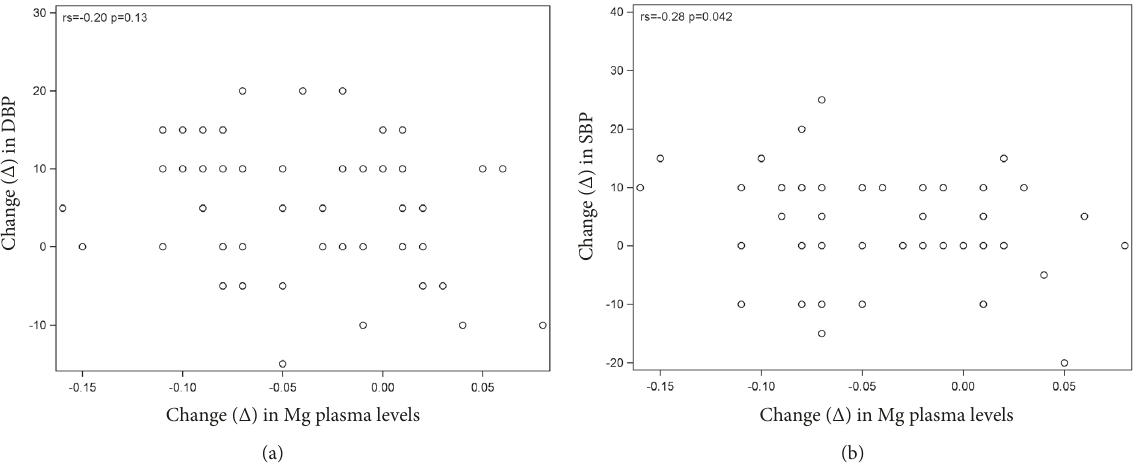
Figure 2: (a) Mg group. Spearman’s correlation between change in DBP from week 12 to week 35 and change in Mg plasma levels from week 12 to week 35. (b) Mg group. Spearman’s correlation between change in SBP from week 12 to week 35 and change in Mg plasma levels from week 12 to week